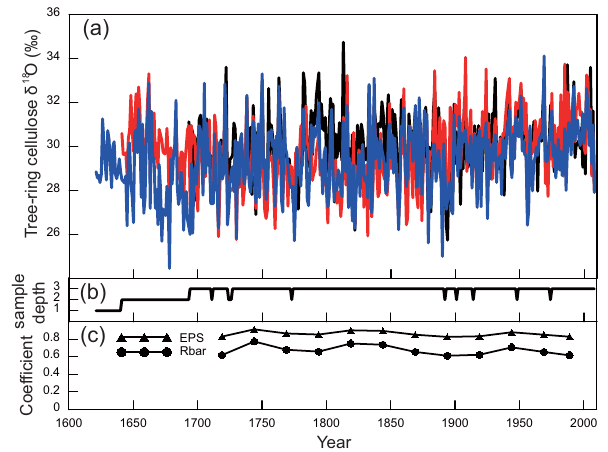
Figure 3. (a) Tree-ring δ 18 O series for three individual trees: (b) sample size and (c) running EPS and Rbar statistics using 50- year windows and a 25-year lag for samples near Jageshwar, India.